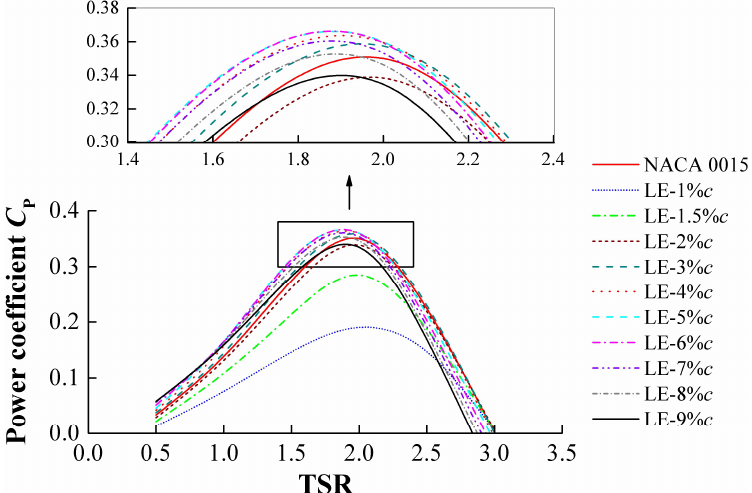
Figure 7. Variation of C P with respect to TSR for the rotors with different airfoil leading edge radius.